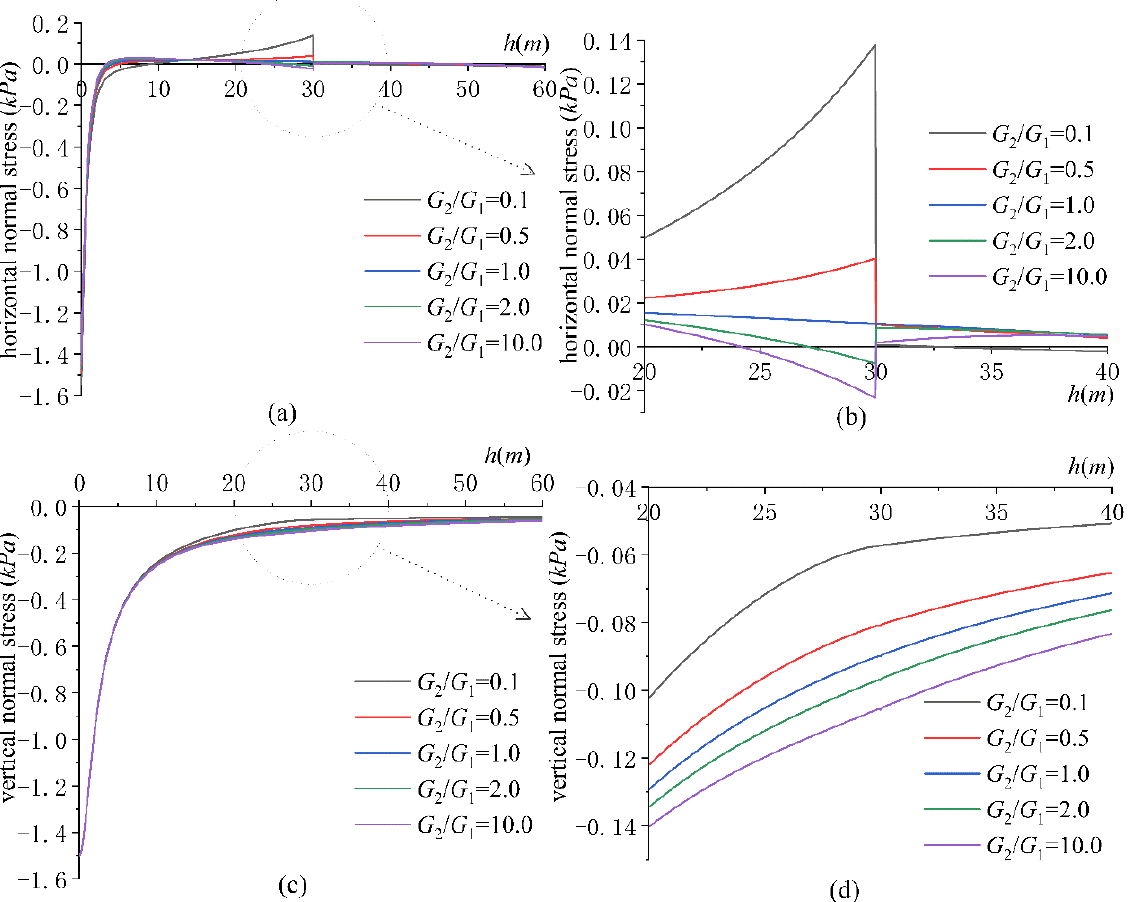
Figure 15. Distribution of horizontal normal stress and vertical normal stress along y -axis. ( a ) Horizontal normal stress, ( b ) Local diagram of horizontal normal stress, ( c ) Vertical normal stress and ( d ) Local diagram of vertical normal stress.